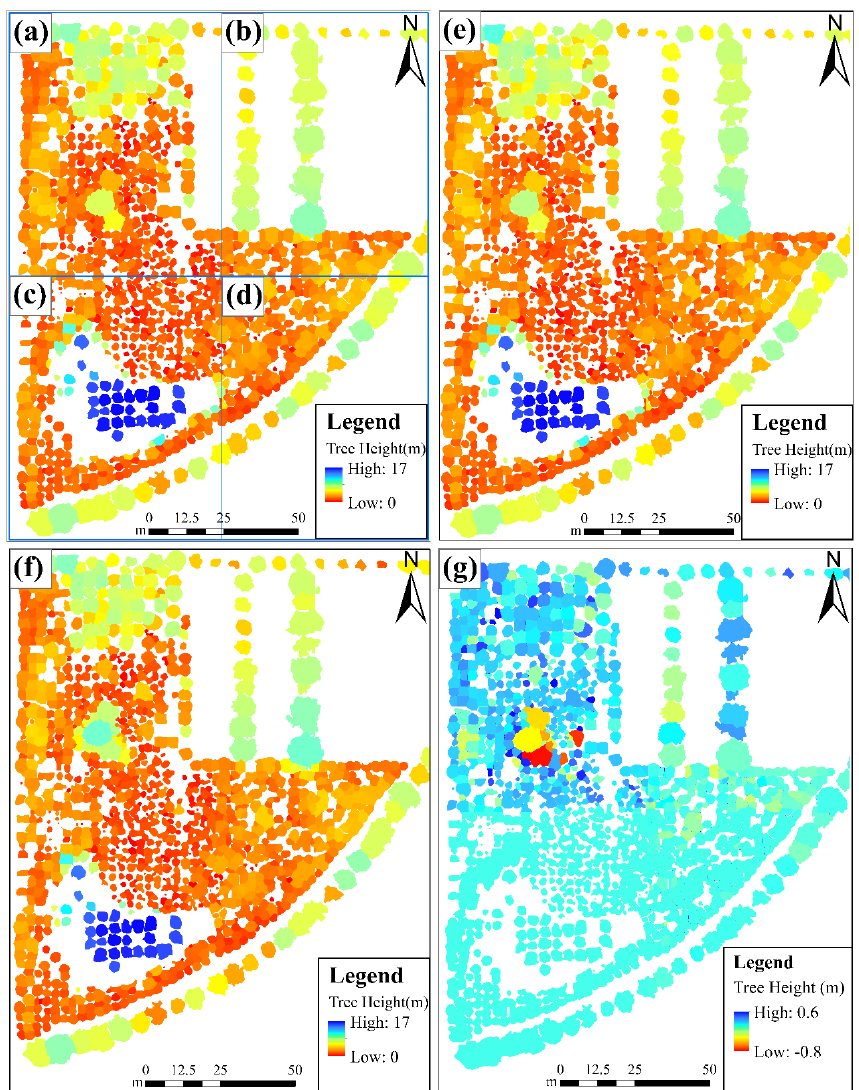
Figure 8. Results of the correction of time differences in regional tree height changes: ( a ) Tree height estimates from June 2020; ( b ) Tree height estimates from July 2020; ( c ) Tree height estimates from October 2020; ( d ) Tree height estimates from September 2020; ( e ) Tree height estimates in October 2020 after time difference correction; ( f ) Tree heights in October 2020 derived from UAV stereo images; and ( g ) Difference between the tree height estimates after time difference correction in addition to the tree height derived from UAV stereo images in October 2020.